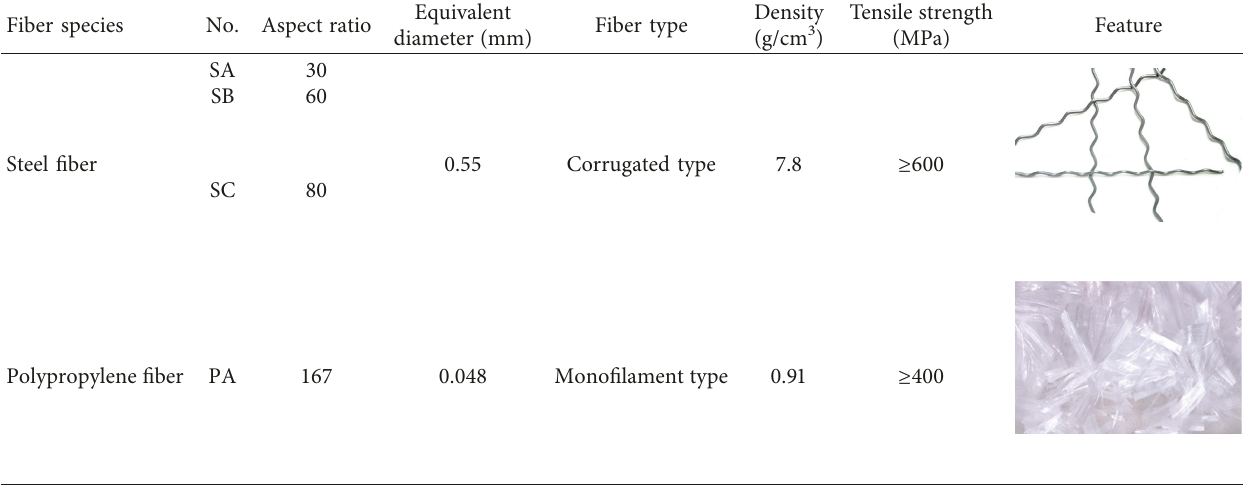
Table 2: Major properties of fibers.